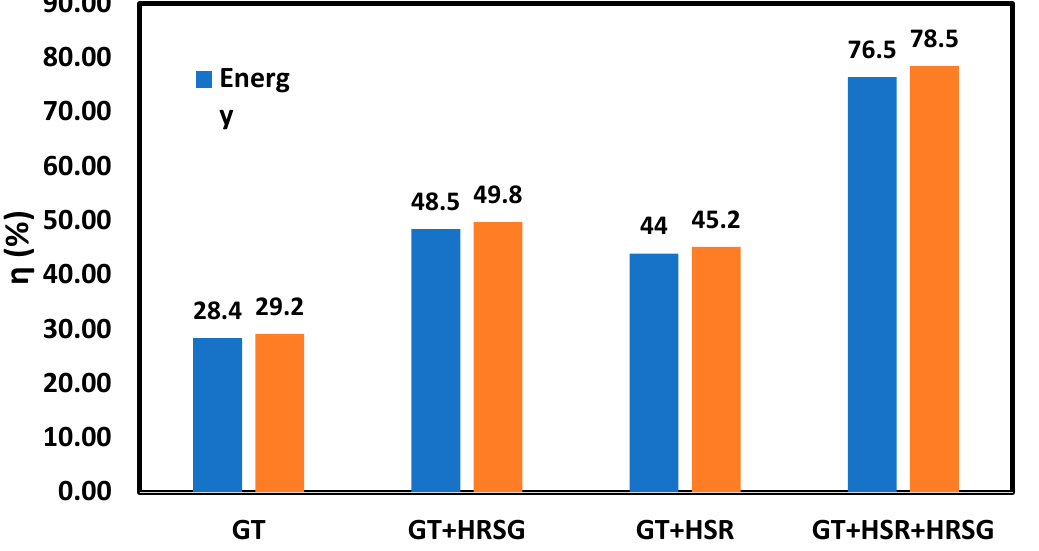
Figure 12. The annual average of energy efficiency for four types.